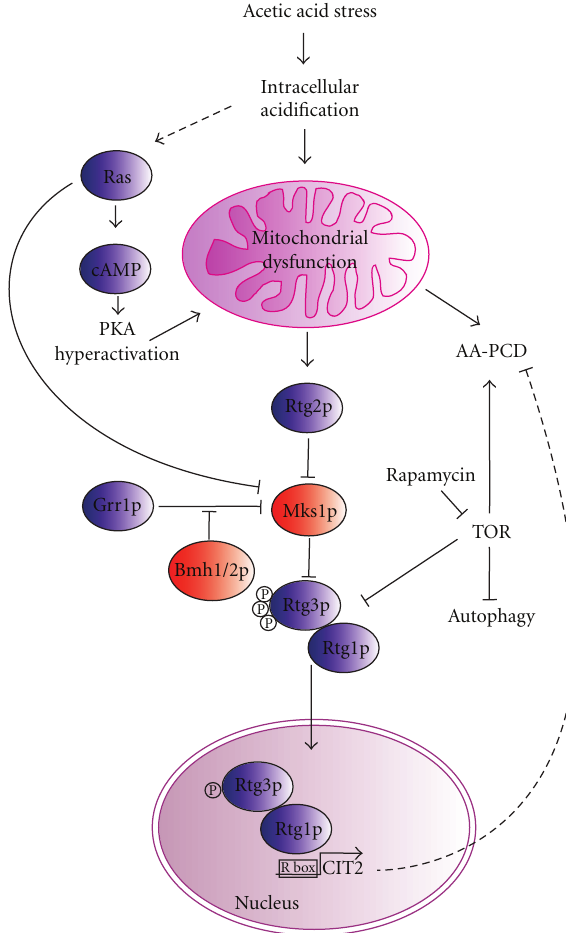
Figure 2: Signaling pathways possibly involved in the interplay between cell death and cytoprotection processes in yeast cells in response to acetic acid stress. Acetic acid causes intracellular acidification, mitochondrial dysfunction, and cell death. TOR pathway is involved in the signaling of AA-PCD; rapamycin inhibition of TOR can trigger autophagy and RTG target gene expression. Dotted lines indicate the hypothetical signaling pathways in AA-PCD regulation in response to mitochondrial dysfunction, on the basis of indirect experimental evidence (see text for details). Intracellular acidification stimulates RAS-cAMP signaling pathway, causing mitochondrial dysfunction, which may lead to AA-PCD or activate retrograde response inducing AA-PCD resistance. RAS pathway negatively regulates Mks1p, a negative regulator of RTG pathway. Positive and negative regulators of RTG pathway are shown in blue and red, respectively. TOR signaling is found at the crossroad of RTG, AA-PCD, and autophagy